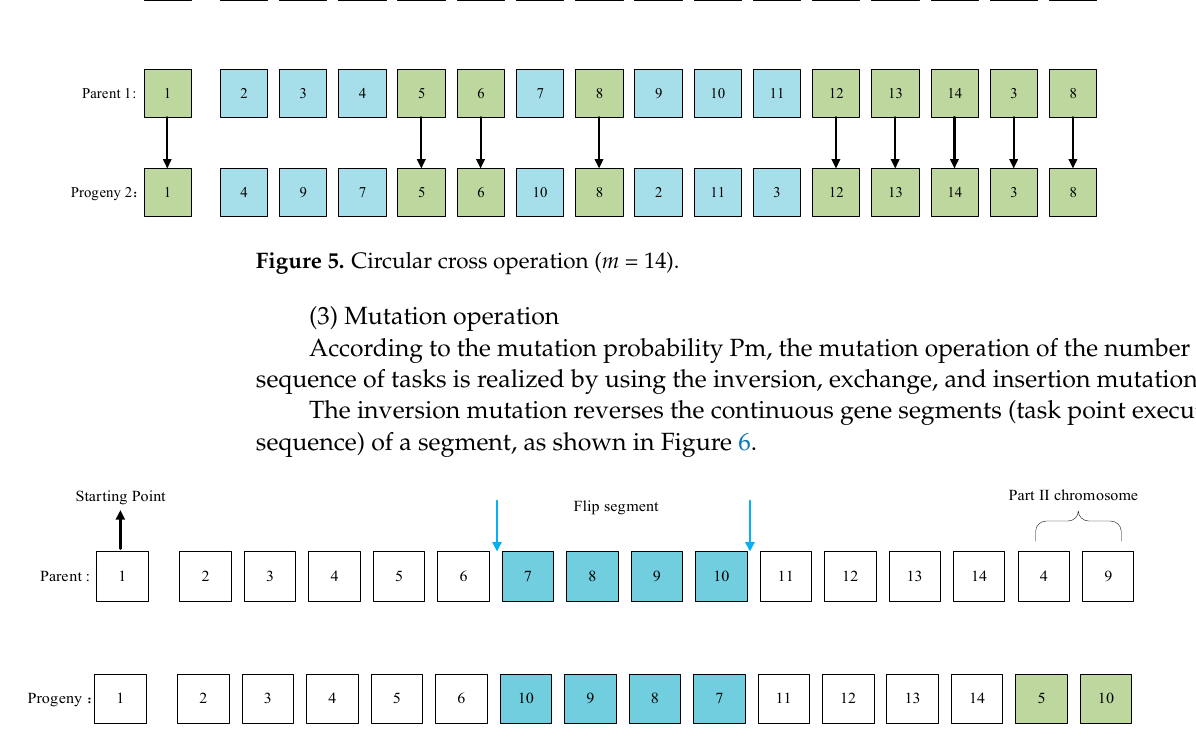
Figure 5. Circular cross operation ( m = 14).